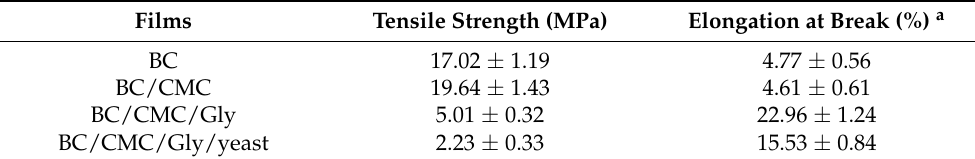
Table 2. Mechanical properties of pristine BC and BC-based different composite films.